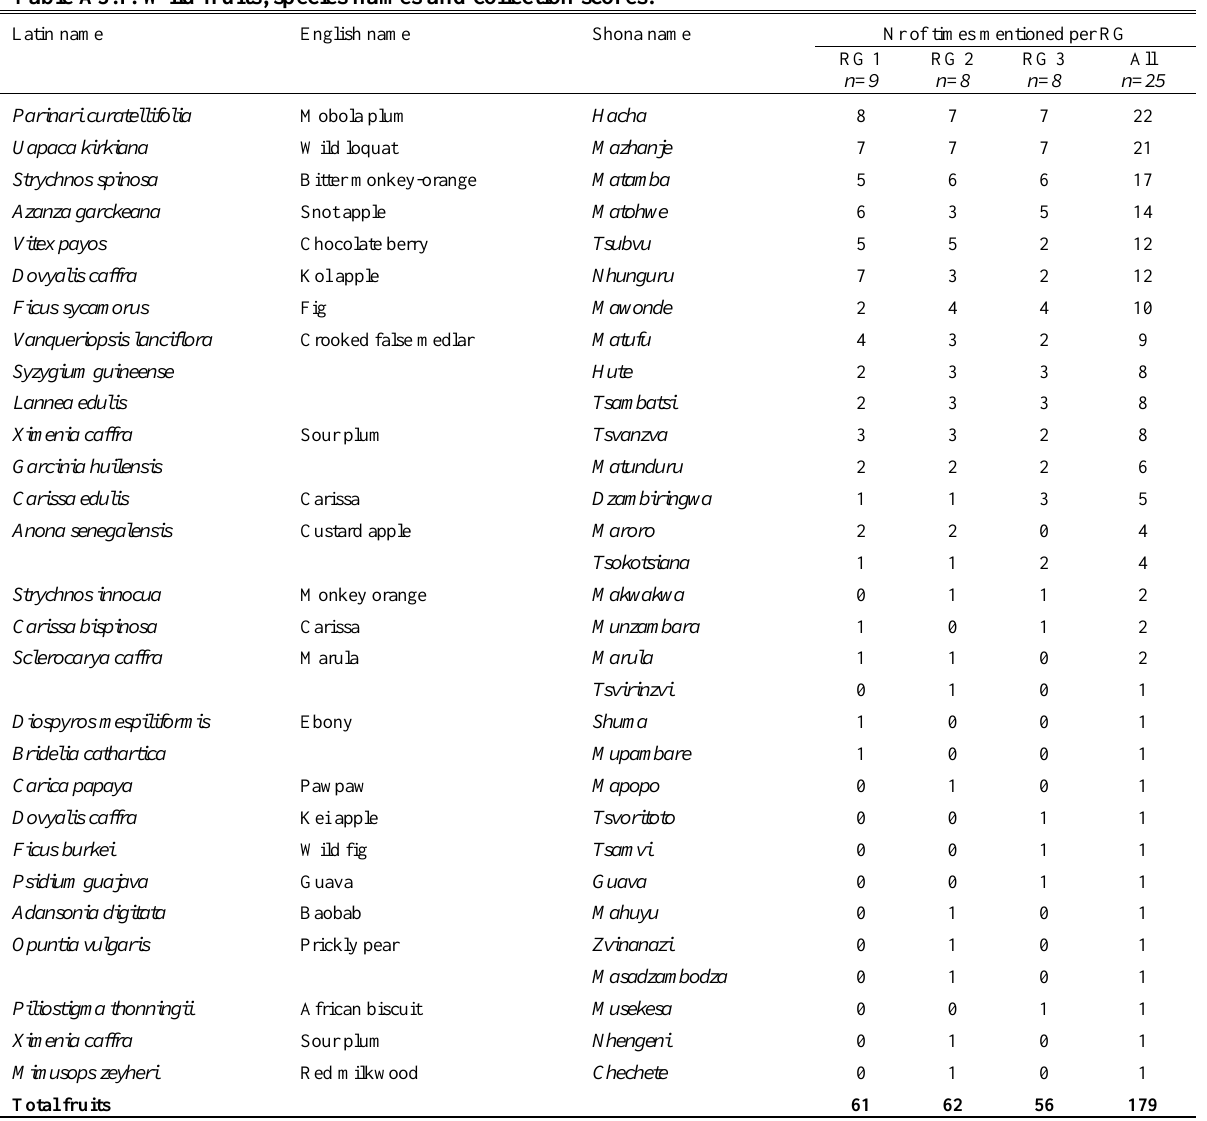
Table A3.1: Wild fruits, species names and collection